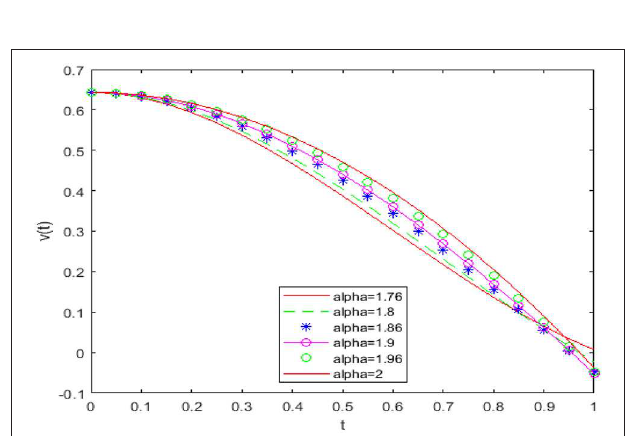
FIGURE 2 | Numerical solutions at α 1.76, 1.8, 1.86, 1.9, 1.96, and 2 for = case 1 at e 0.8 and f 0.8. = =